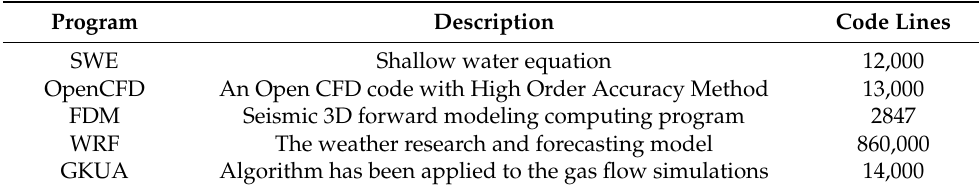
Table 1. Scientific computation programs with large